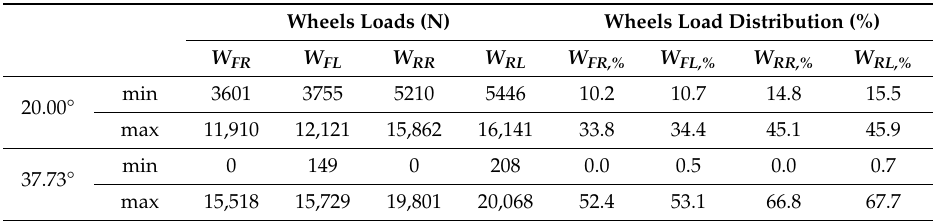
Table 5. Maximum and minimum values recorded during a complete rotation of the turntable for α = 20.00 ◦ and α = 37.73 ◦ (incipient rollover).